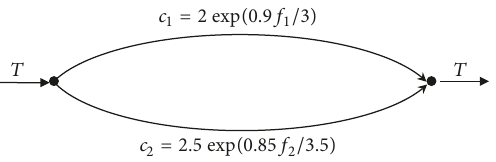
1 Figure 6: Simple network with exponential cost functions.